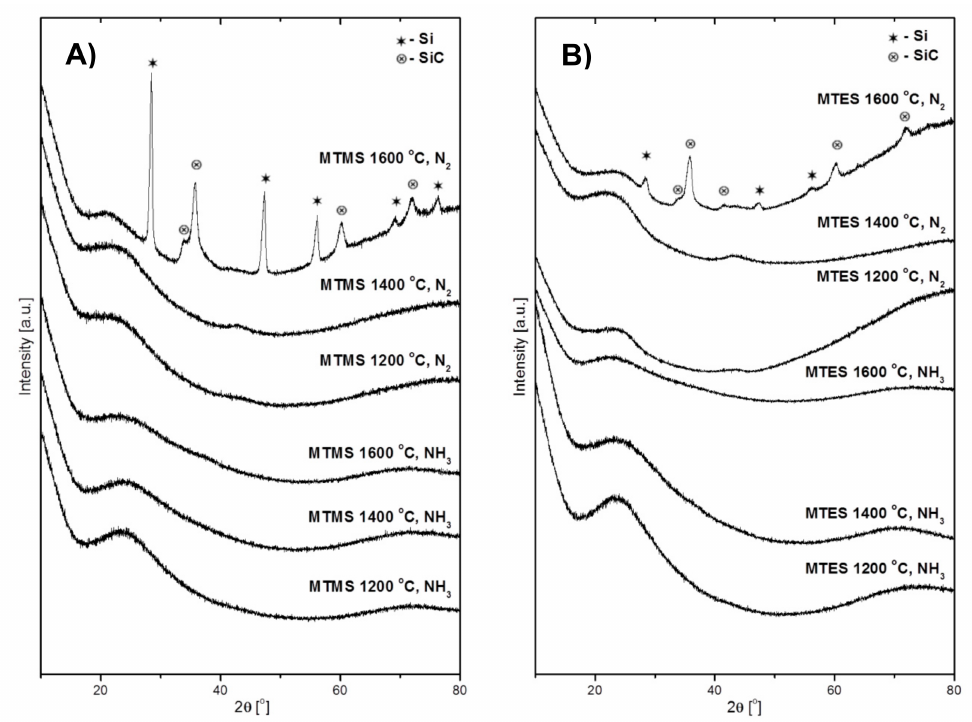
Figure 3. The XRD patterns of powders produced by spray pyrolysis at different conditions. ( A )—from MTMS, ( B )—from